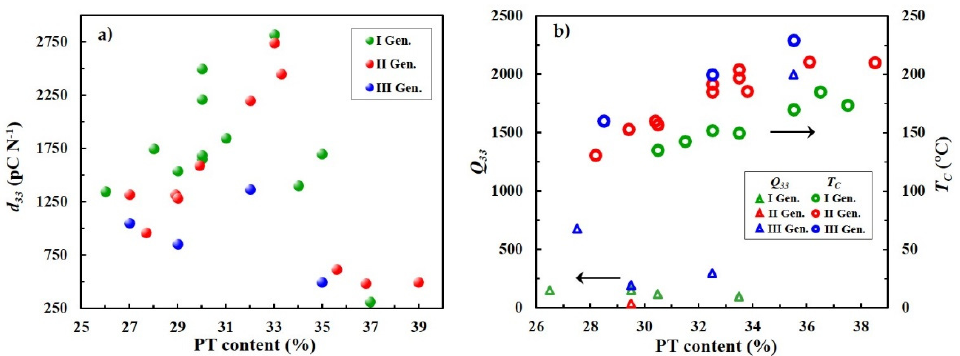
Figure 1. Property comparisons between three generation crystals (PMN-PT, PIN-PMN-PT and Mn:PIN-PMN-PT). ( a ) longitudinal piezoelectric coefficient. ( b ) longitudinal mechanical quality fac- tor and the Curie temperature. Data from ref. [15,23,25–42].